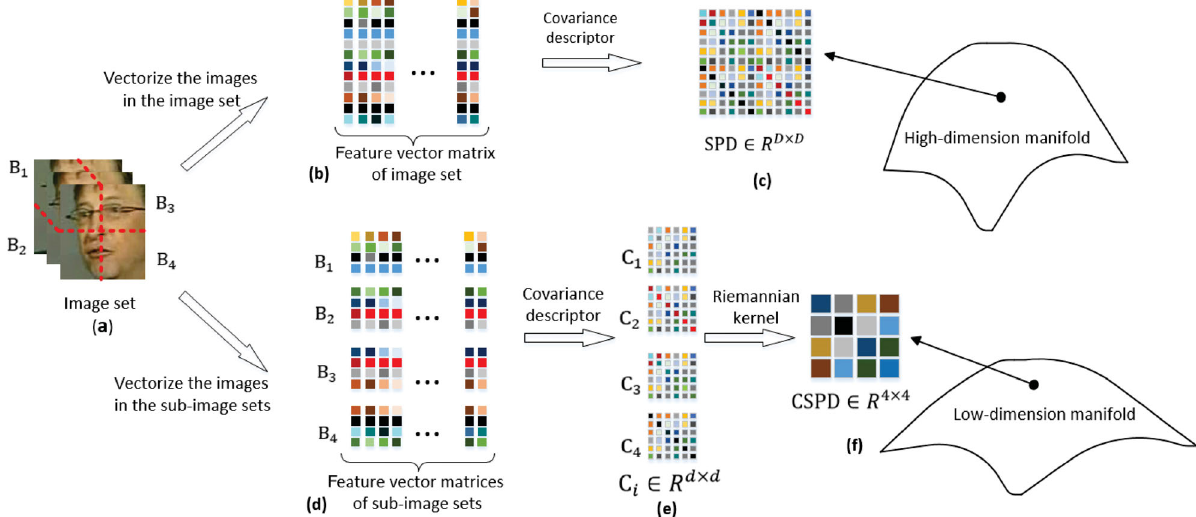
Fig. 1 Processing an image set using the traditional SPD approach and our CSPD approach. Above: traditional SPD. The SPD matrix is computed using a covariance descriptor; it lies on a non-linear SPD manifold. Below: our CSPD approach. It firstly divides images in the set into square blocks of the same size. The i -th sub-image set B i is represented by a traditional SPD model. The Riemannian kernel is then used to describe the similarity between the sub-image sets. The final CSPD appears in the form of the Riemannian kernel matrix of the representations of sub-image